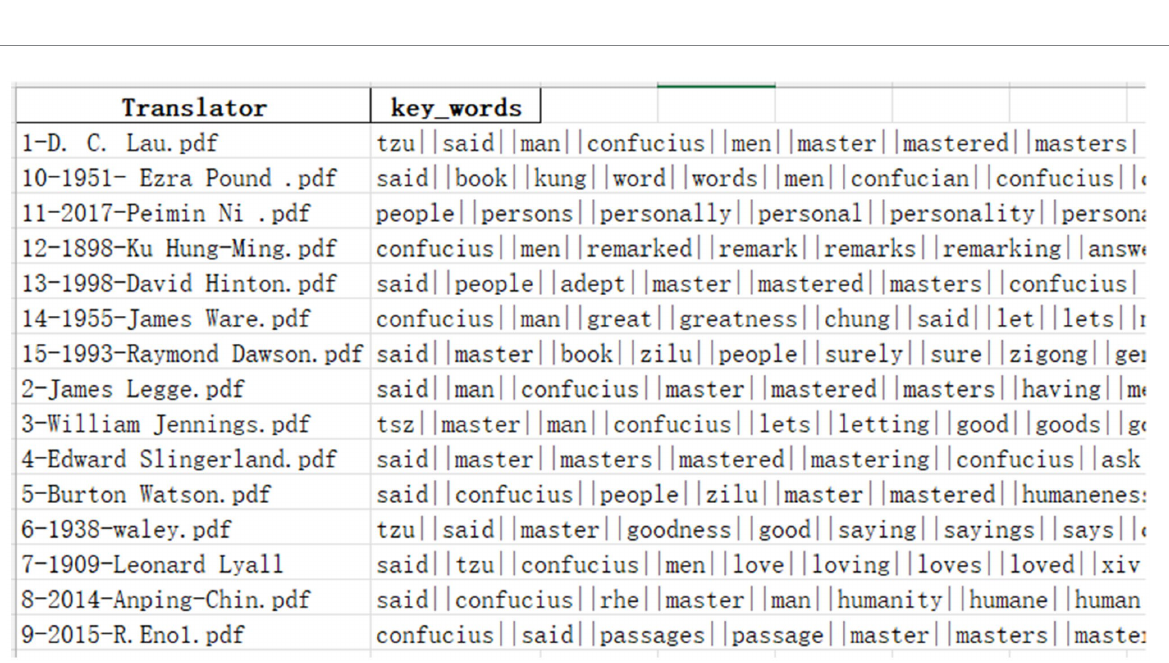
FIGURE 2 Examples of keyword features in different